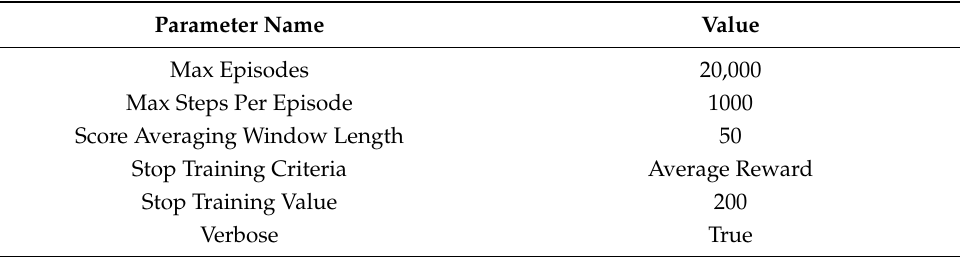
Table 4. Neural networks training